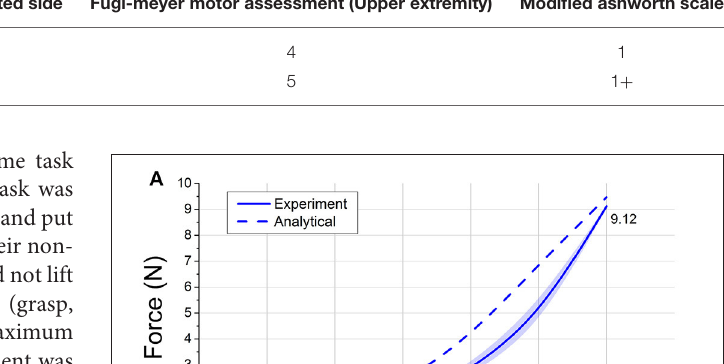
TABLE 2 | Stroke patients’ demographic data. Sex (age)